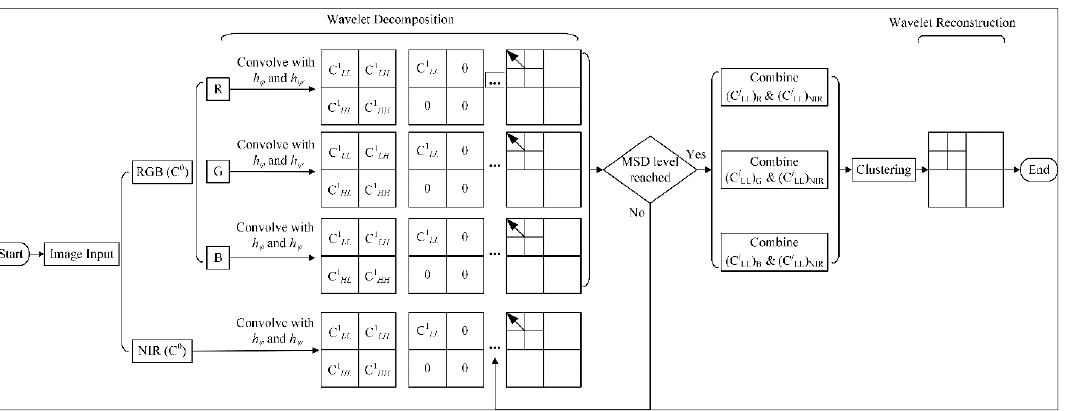
Figure 6. Entropy filter of RGB citrus fruit color image, ( a ) VIS color image; ( b ) Entropy filter of R component in level 3 of DWT; ( c ) Entropy filter of G component in level 3 of DWT; ( d ) Entropy filter of B component in level 3 of DWT. Figure 5. Fusion on color and near infrared images with DWT.